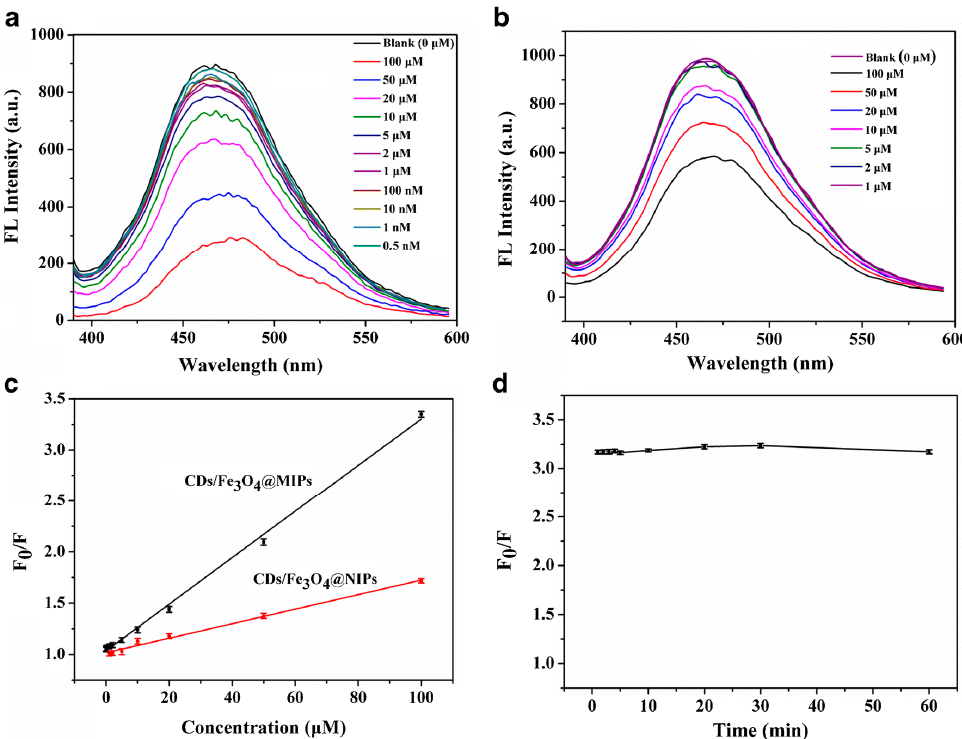
Figure 12. ( a ) FL emission spectra of CDs/Fe 3 O 4 @MIPs with TNP concentrations of 0–100 µM. ( b ) FL emission spectra of CDs/Fe 3 O 4 @NIPs with TNP concentrations of 0–100 µM. ( c ) Calibration curve toward TNP. ( d ) Dynamic adsorption curve of CDs/Fe 3 O 4 @MIPs. Reprinted with permission from [76]. Copyright (2019) Springer-Verlag GmbH Austria, part of Springer Nature.